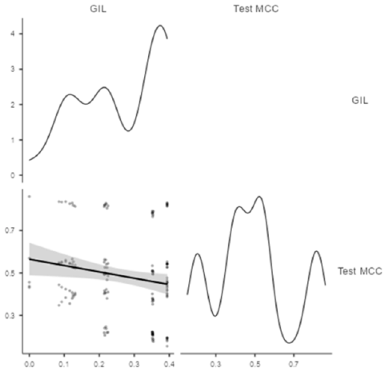
Figure 5. The scatterplot depicting the correlation between GIL and MCC ( bottom left ) and the respective densities of the GIL ( upper left ) and MCC ( bottom right ) metric values.